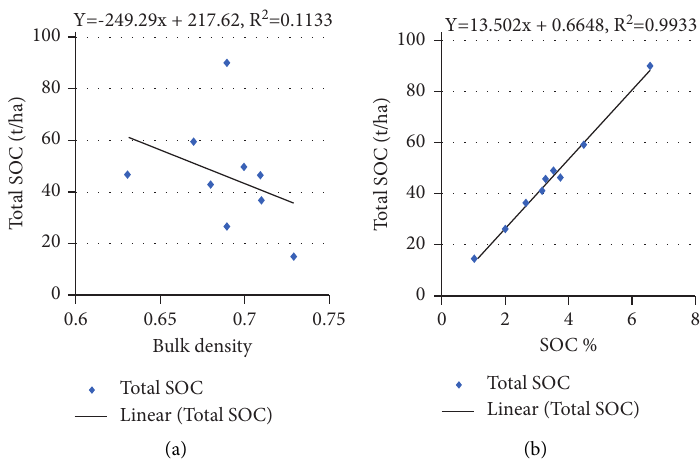
Figure 6: (a) SOC stocks (t/ha) and BD. (b) SOC stock (t/ha) with SOC concentration in oak